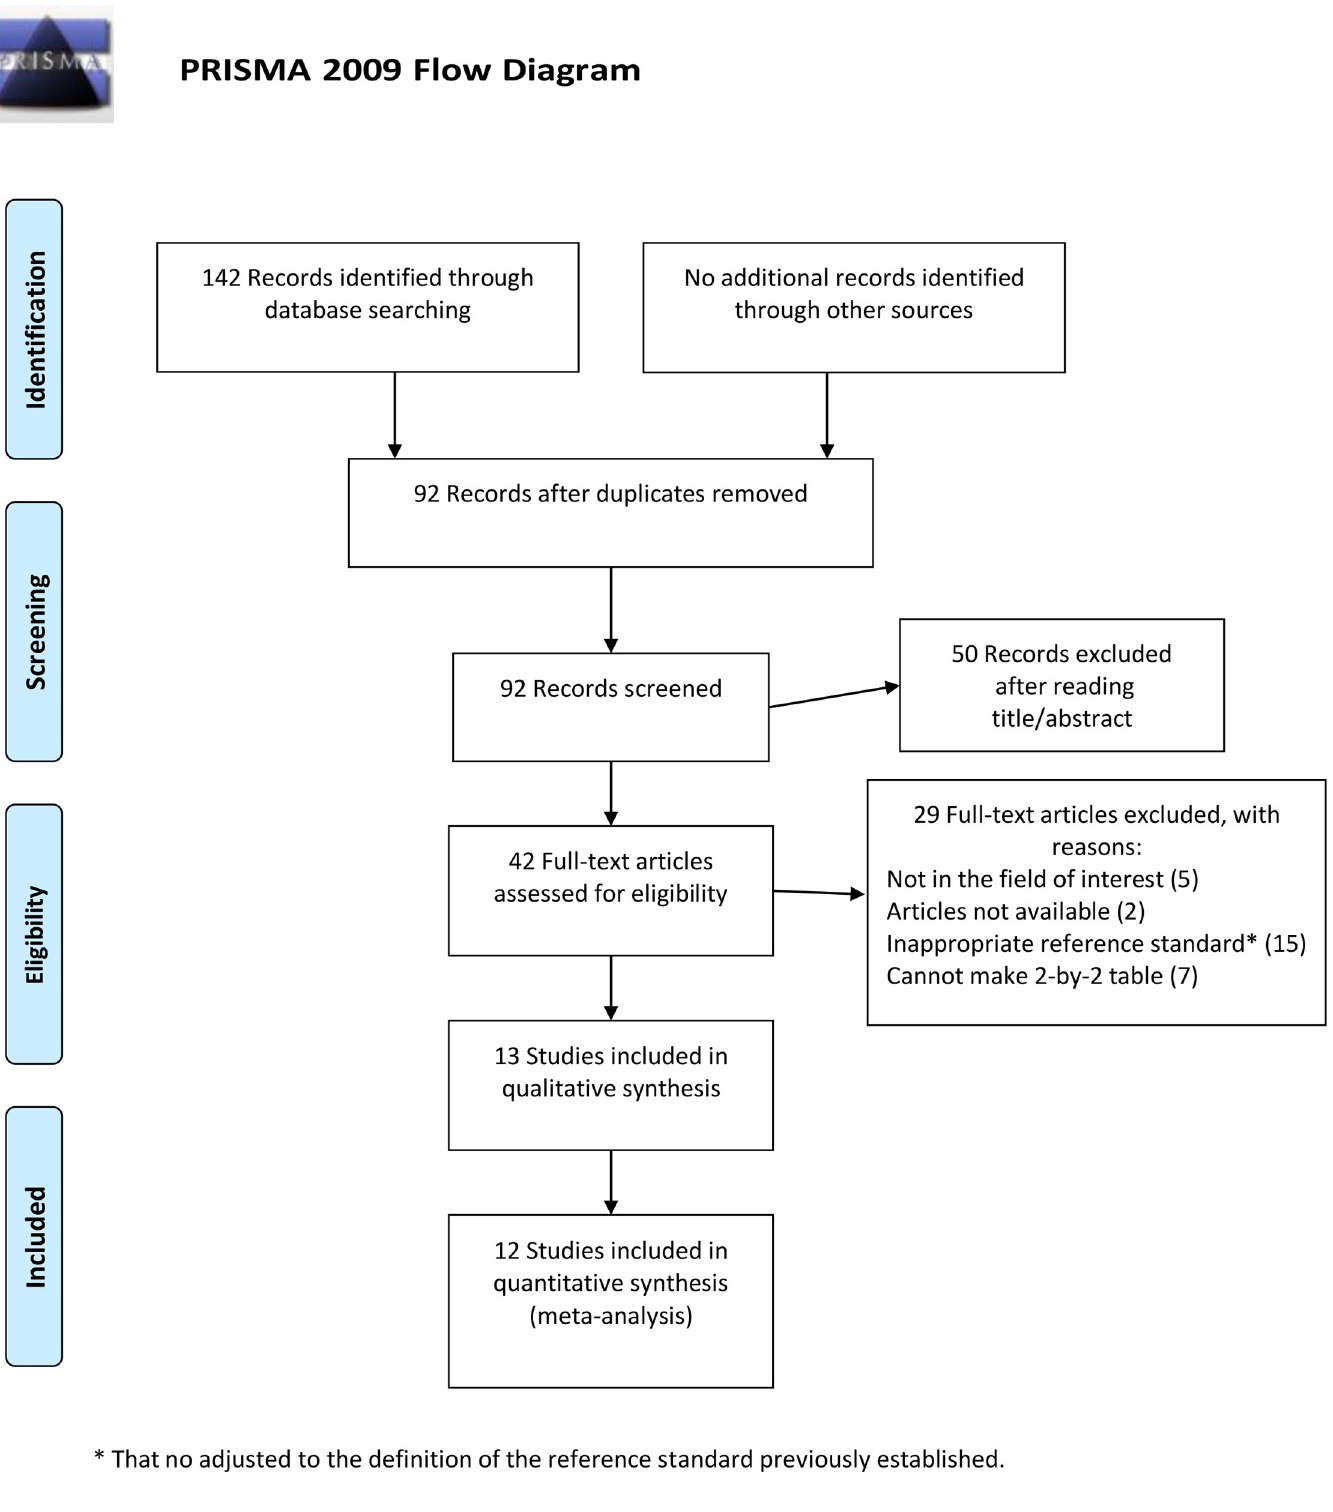
Fig 1. Flow chart of included studies.